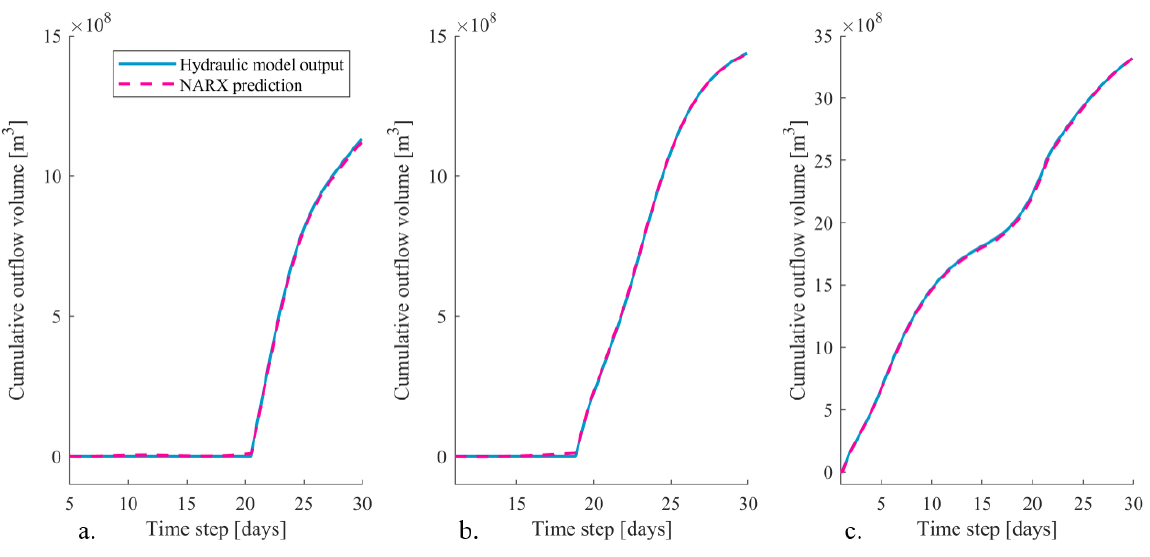
Figure 12. ( a – c ) The cumulative outflow volume over time for the IJssel river breach location predicted by the hydraulic model and the NARX network as a result of the upstream discharge waves presented in Figure